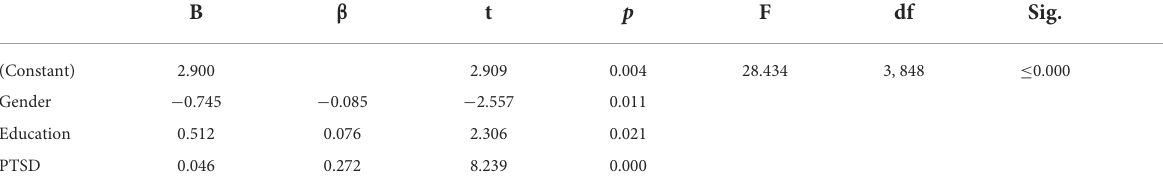
TABLE 12 Linear regression summary for negative schizotypy.